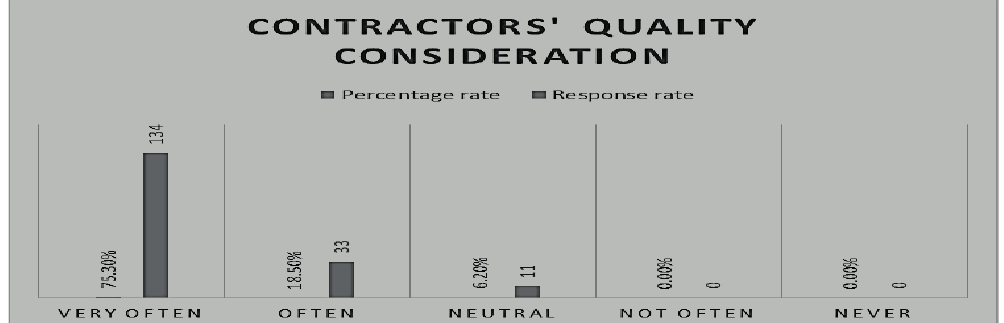
Fig. 1. Level of consideration of quality in the housing delivery process. Source : The authors’ field survey